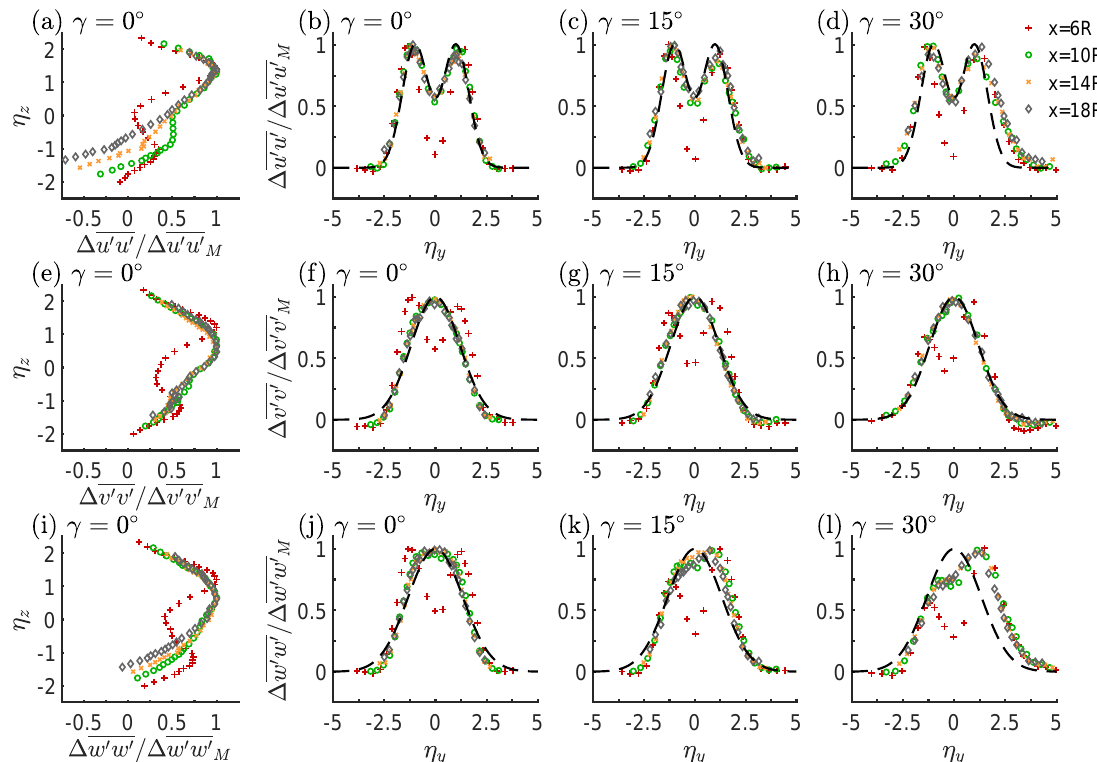
Figure 13. Vertical and lateral profiles of the normalised diagonal components of the added Reynolds u (cid:48) u (cid:48) stress tensor ∆ u (cid:48) / ∆ u (cid:48) versus η z and η y in the wake of the model wind turbine immersed in i i i iM the SBL. Black dashed line denotes the distributions ( b )–( d ) f 1 = e − 1.25 ( η 2 y − 1 ) + e − 1.25 ( η 2 y + 1 ) , ( f )–( h ) f 2 = e − 0.35 η 2 y and ( j )–( l ) f 3 = e − 0.28 η 2 y . The legend indicates the downstream